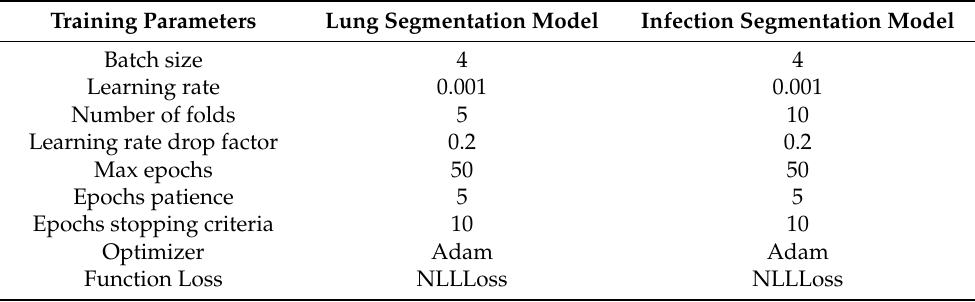
Table 3. Details of lung/lesion segmentation model training